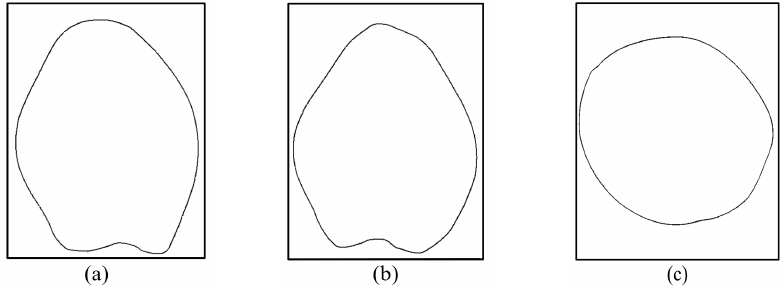
Figure 8. Contour obtained by plane A , B , and C tangent to the fruit model. ( a ) Contour obtained by plane A tangent to the fruit model. ( b ) Contour obtained by plane C tangent to the fruit model. ( c ) Contour obtained by plane B tangent to the fruit